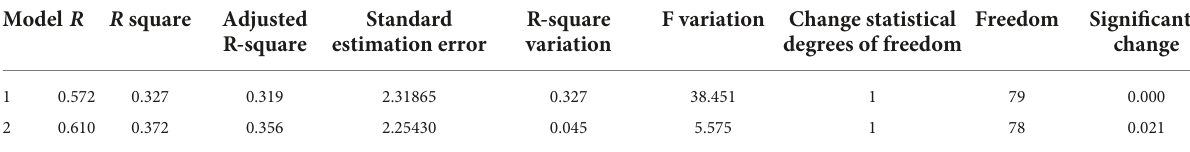
TABLE 4 Summary of regression models.